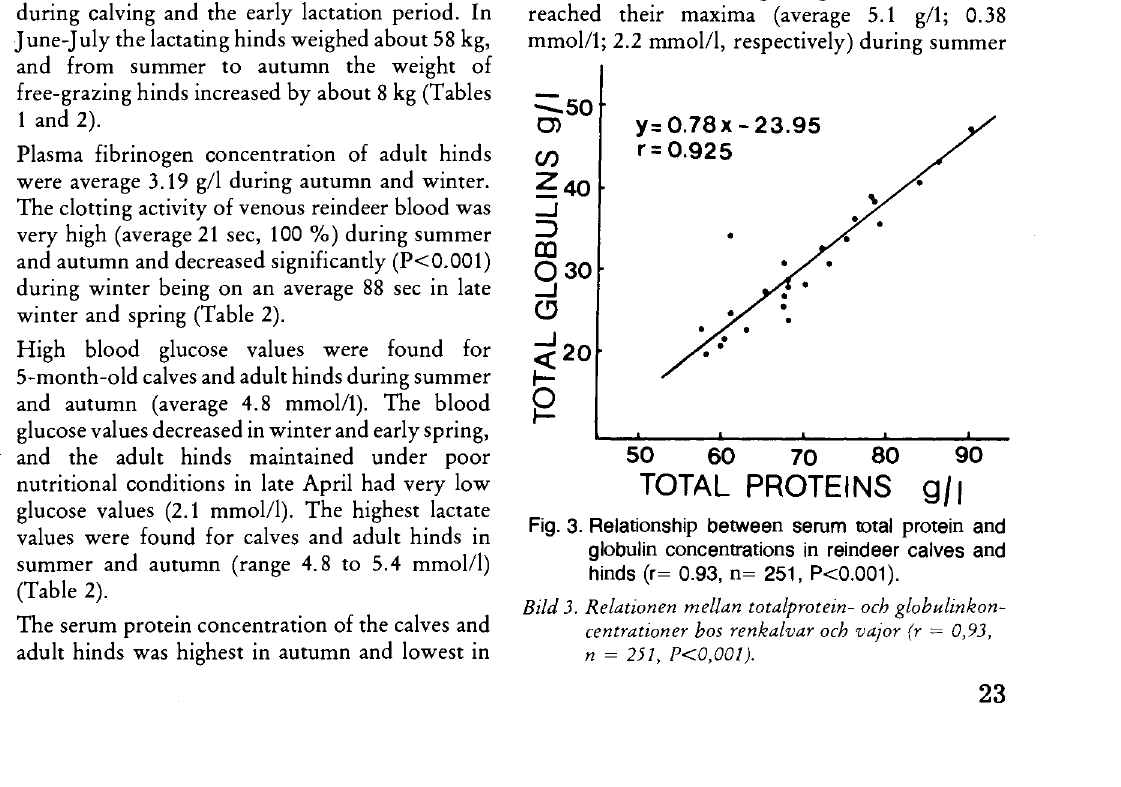
Fig. 2. Relationship between body weight and serum alkaline phosphatase activity (SAP) in reindeer calves (r= —0.88, n= 306, P<0.001). Bild 2. Relationen mellan kroppsvikt och serum alkalin- fosfatasaktivitet (SAP) hos renkalvar (r = —0,88, n = 306, P<0,001).